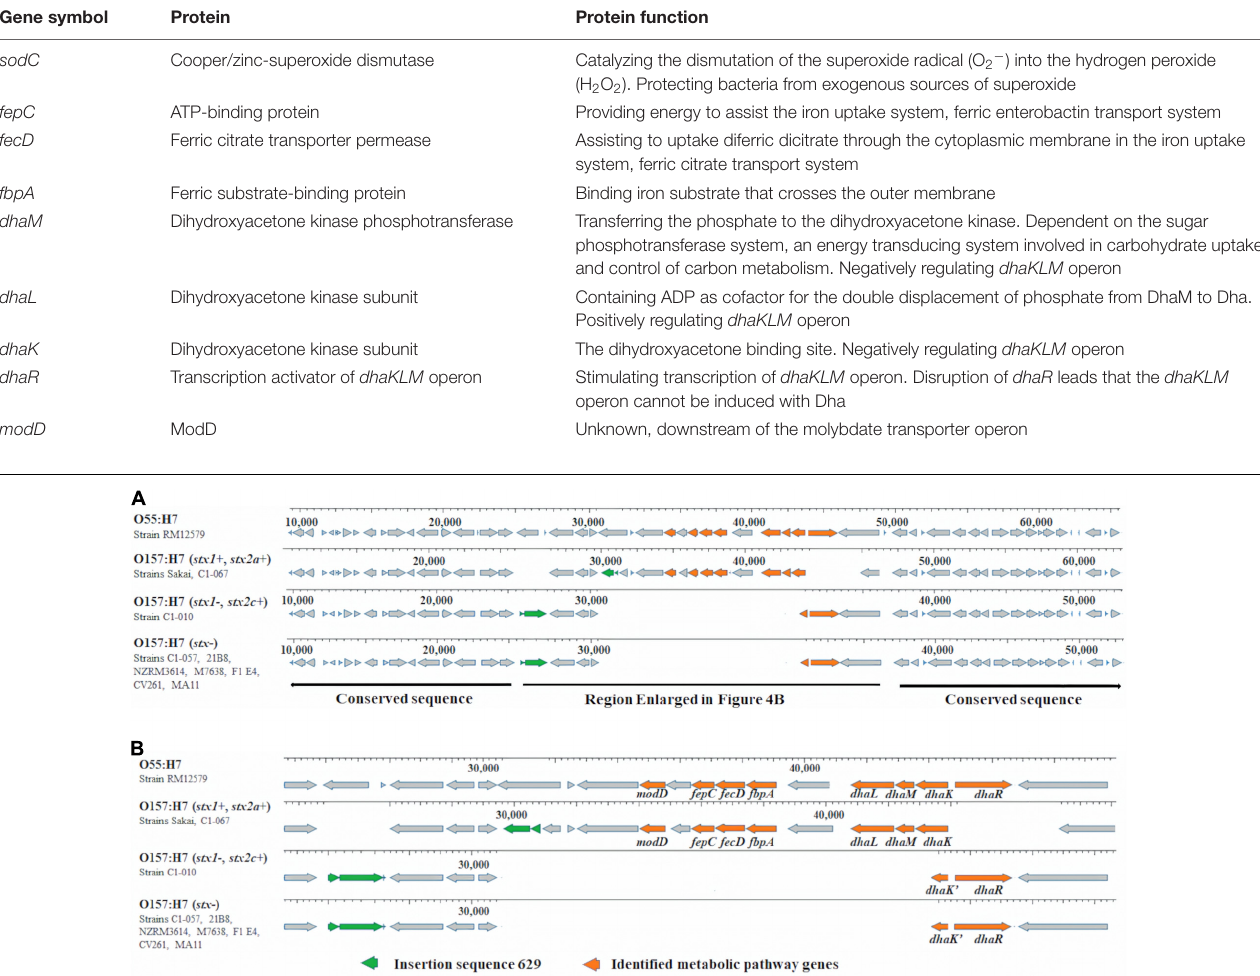
FIGURE 4 | (A) Unique metabolic pathway genes and IS629 in 10 Escherichia coli O157:H7 strains within a conserved region and metabolic pathway genes in 1 Escherichia coli O55:H7 strain within the corresponding conserved region. (B) Enlarged region in (A) .